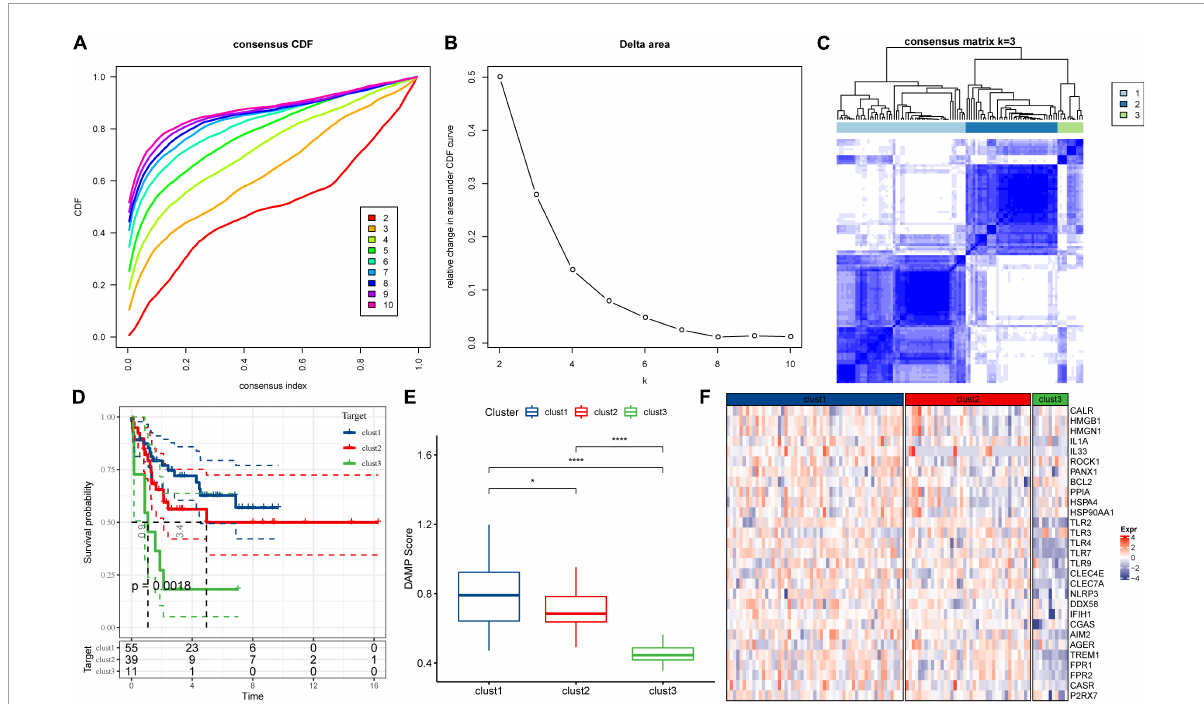
FIGURE1 Consensus clustering of molecular subtypes in acute lymphoblastic leukemia depending on damage-associated molecular patterns-associated differentially expressed genes. (A) Cumulative distribution function (CDF) curve of Target dataset samples. (B) CDF Delta area curve. The relative change in the area under the curve for each category number k in comparison with k − 1 is displayed. The number k is indicated by the horizontal axis and the relative change in the area under the curve is represented by the vertical axis. (C) The heatmap for the consensus matrix with k = 3. (D) K-M survival curves showed the differences of among the three clusters. (E) Comparison of DAMPs scores of the three subtypes in the Target dataset. (F) Heatmap of DAMPs-related gene expression between different molecular subtypes. * p < 0.05; ** p < 0.01; *** p < 0.001; **** p < 0.0001; ns: no